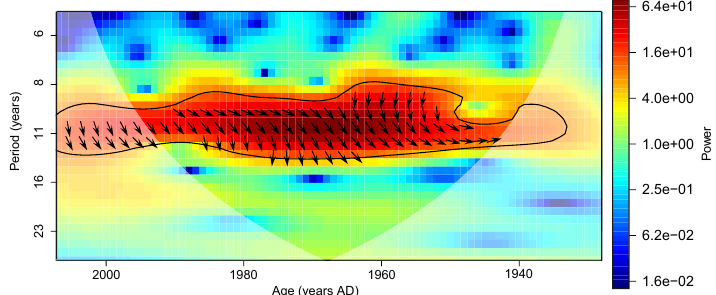
Figure 5. Cross-wavelet analysis of MJJA River Ammer flood frequency composite and total solar irradiance (TSI) (Lean, 2000) indicating significant common spectral power (exceeding the 90% significance level against a red noise spectrum) around 11 years. Arrows pointing down indicate that TSI leads the River Ammer flood frequency composite. Before the analysis the River Ammer flood frequency composite was filtered with a 5-year running mean. Shaded areas indicate the cone of influence where wavelet analysis is affected by edge effects.